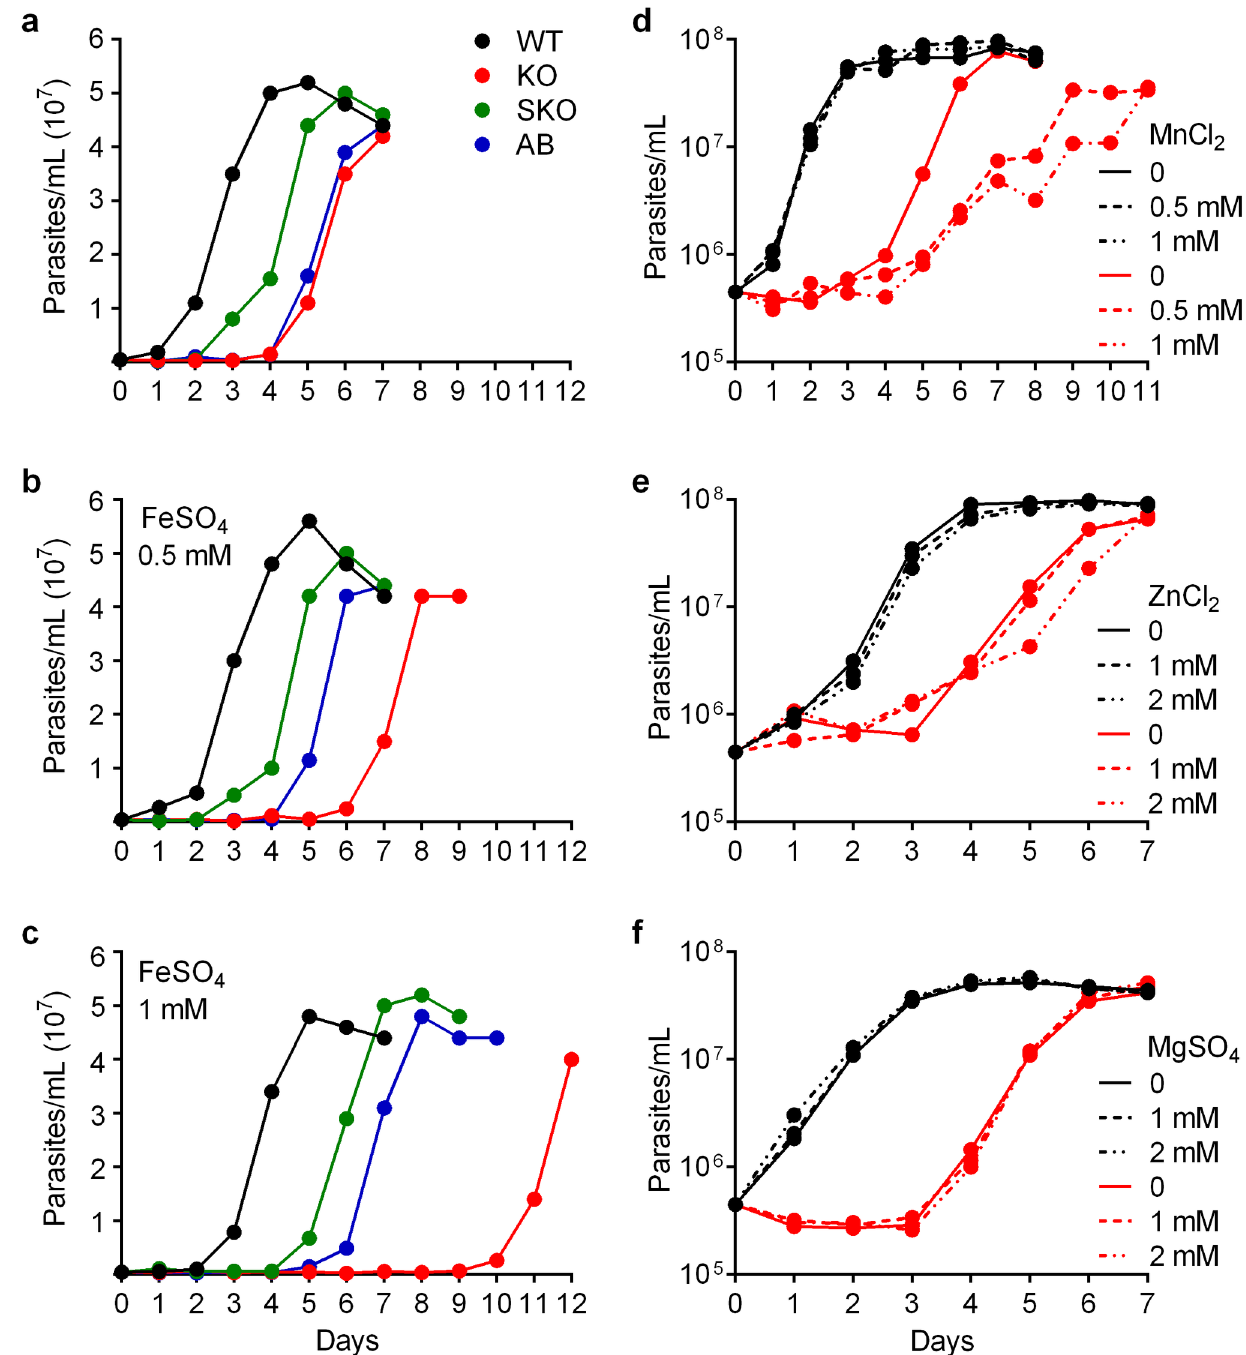
Fig 5. LIR1 deficiency enhances the toxic effect of excess iron and other transition metals during promastigote replication. (a-c) Growth curves of wild type (WT), LIR1 single knockout (SKO), LIR1 double knockout (KO) and add-back (AB) L . amazonensis promastigotes in regular growth medium (a) or in the same medium containing extra iron: 0.5 mM (b) and 1 mM (c) FeSO 4 . The values correspond to the average of triplicate determinations, in one experiment that is representative of 3 independent experiments (see also supplementary S4 Fig). (d-f) Growth curves of wild type (WT) and LIR1 double knockout (KO) promastigotes in regular growth medium (continuous lines) or in the same medium supplemented with (dotted lines) (d) 0.5 and 1 mM MnCl 2 , (e) 1 and 2 mM ZnCl 2, (f) 1 and 2 mM MgSO 4 . The values correspond to the average of triplicate determinations, in one experiment that is representative of 2 independent experiments.